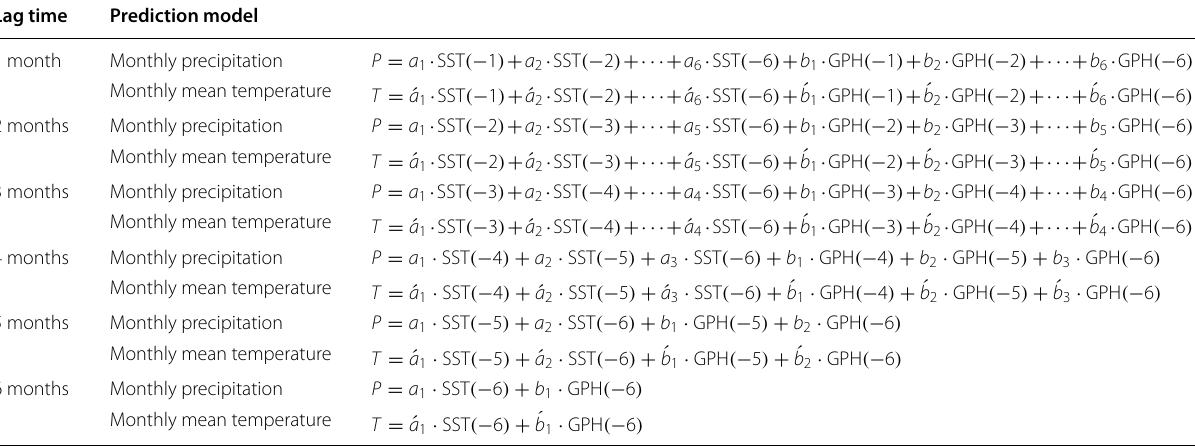
Table 5 Temperature and precipitation prediction model based on the teleconnection as a function of the lag time Lag time Prediction